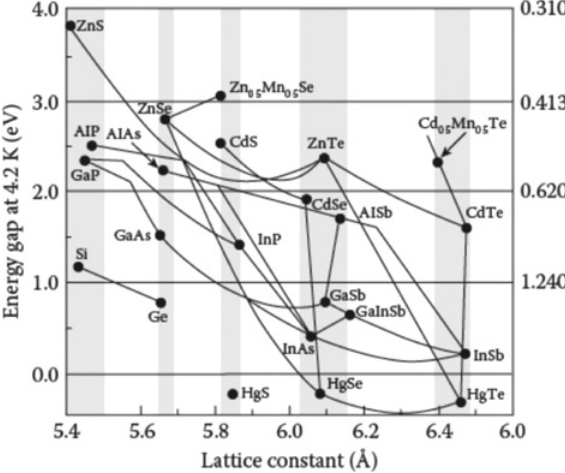
Figure 3: Schematic of the conduction energy band profile for a GaAs/AlGaAs QWIP under zero (above) and finite (below)